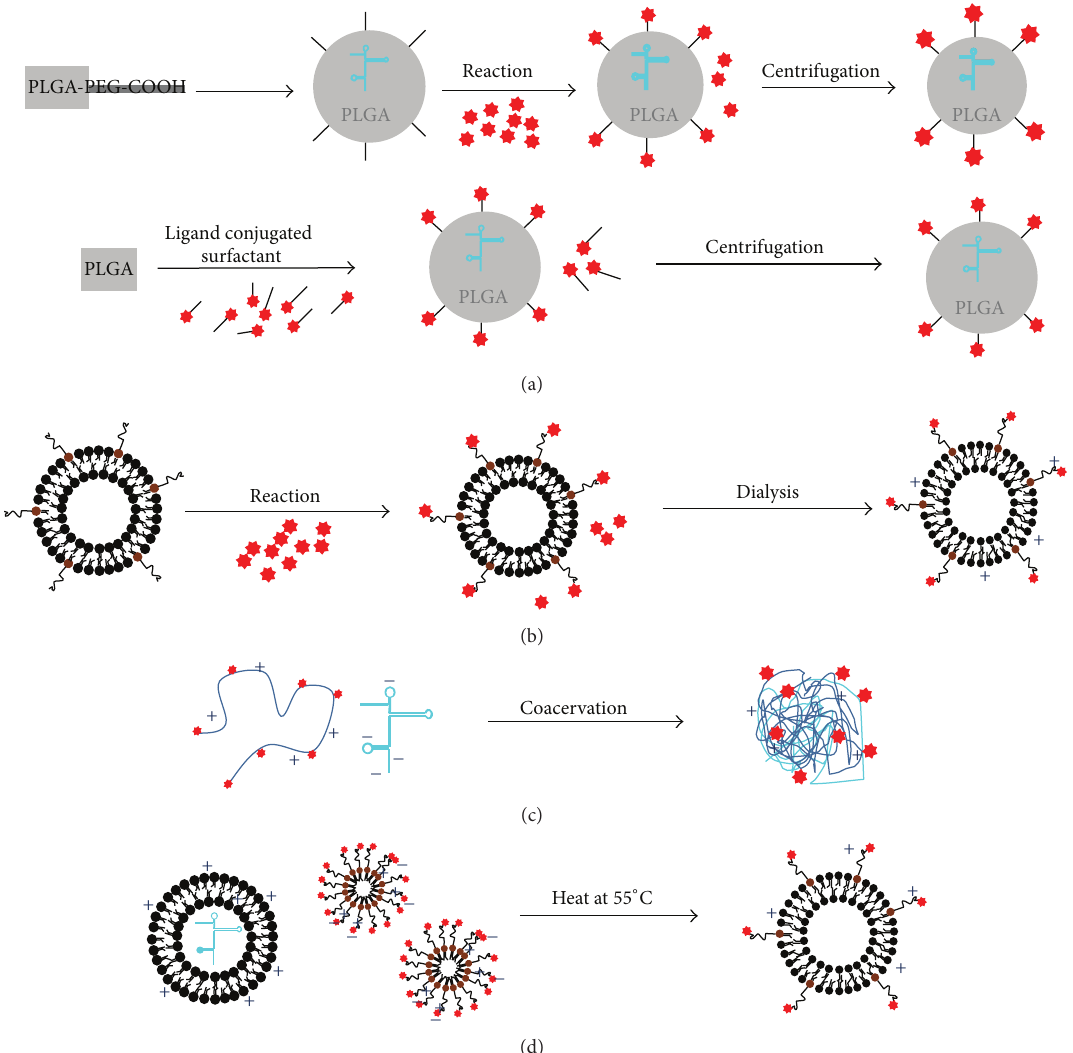
Figure 1: Established strategies for the conjugation of ligands onto polymeric and liposomal nanoparticles. (a) (Top) PLGA (poly(lactic- co-glycolic acid)) nanoparticles formed by copolymer PLGA-PEG-COOH are stabilized with normal surfactant and subsequently reacted with ligands bearing compatible linking groups. (Bottom) PLGA nanoparticles are stabilized with amphiphilic surfactants containing functionalizable molecules. PLGA nanoparticles, susceptible to hydrolysis, are purified by centrifugation to reduce water exposure time. (b) DC-targeting antibodies bearing compatible cross-linkers (e.g., -SH) are reacted with preformed liposomes to form immunoliposomes, which are purified by dialysis. (c) Electrostatically neutral ligands (mannose) are covalently conjugated to cationic polymers and directly used to formulate targeted nanoparticles. (d) Postinsertion functionalization of liposomes/lipopolyplexes. Formulated liposomes/lipopolyplexes are heated with micelles bearing targeting ligands at 55 ∘ C for at least 15 mins. The resultant ligand conjugated liposomes/lipopolyplexes can be used without further